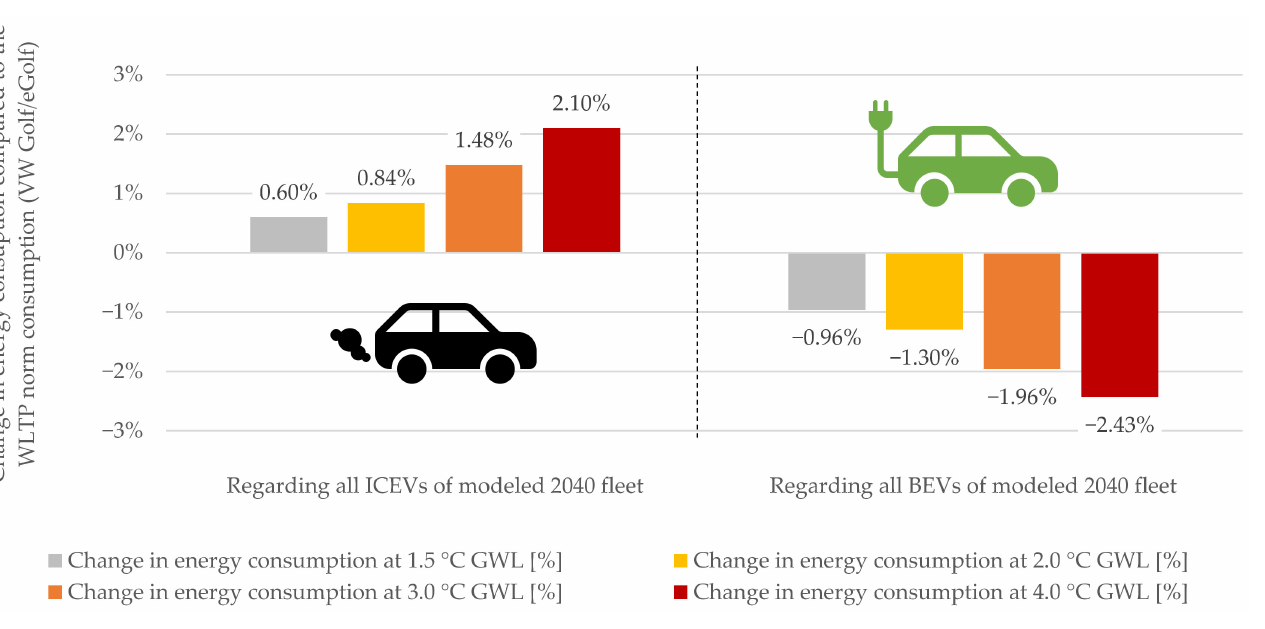
Figure 6. Average change in the annual energy consumption of a VW Golf 1.0l eTSI ( left ) and a VW eGolf ( right ) calculated for different global warming levels (GWL) based on the MiD